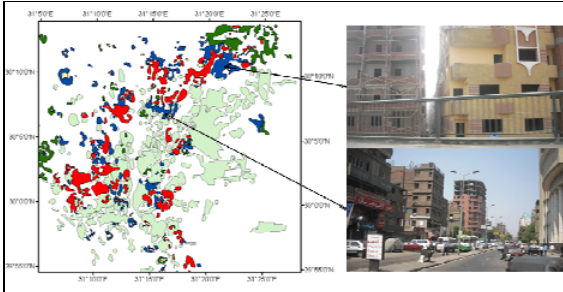
Figure 6. Field observations are showing empty buildings in high density classified